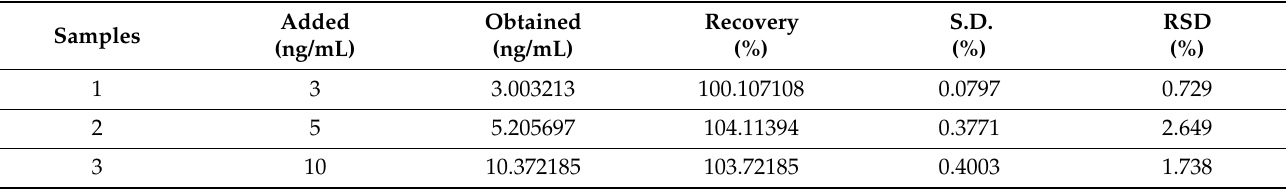
Table 1. Test results of standard recovery test (n = 3).